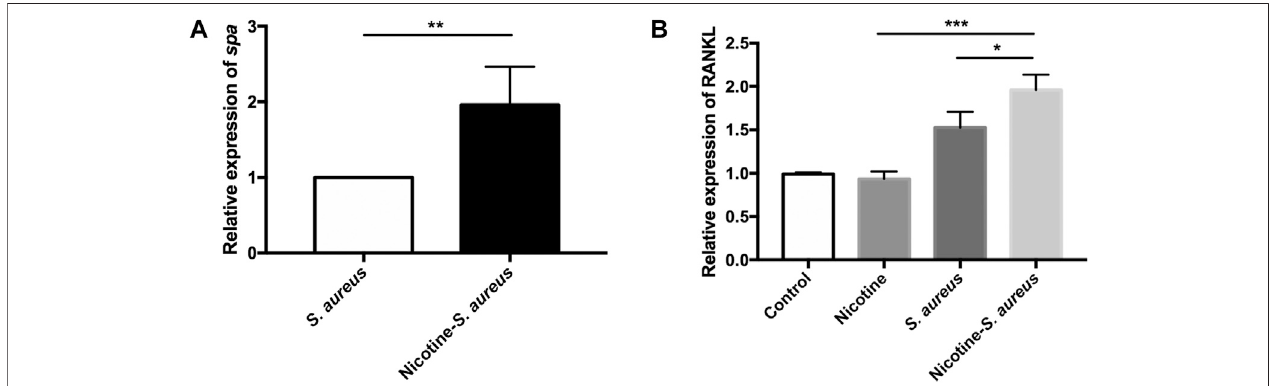
FIGURE5| Nicotineupregulatedthevirulenceof S.aureus andsynergisticallyactivatedtheRANKLpathway. (A) Relativeexpressionof spa in S.aureus ornicotine- treated S. aureus measured by RT-qPCR. All gene expression levels were normalized by 16s rRNA gene expression. (B) Relative expression of nuclear factor-kappa B ligand (RANKL) in MC3T3-E1 in the presence of nicotine, S. aureus , or both, measured by RT-qPCR. All gene expression levels were normalized by β -actin gene expression. * p < 0.05. ** p < 0.01. *** p <